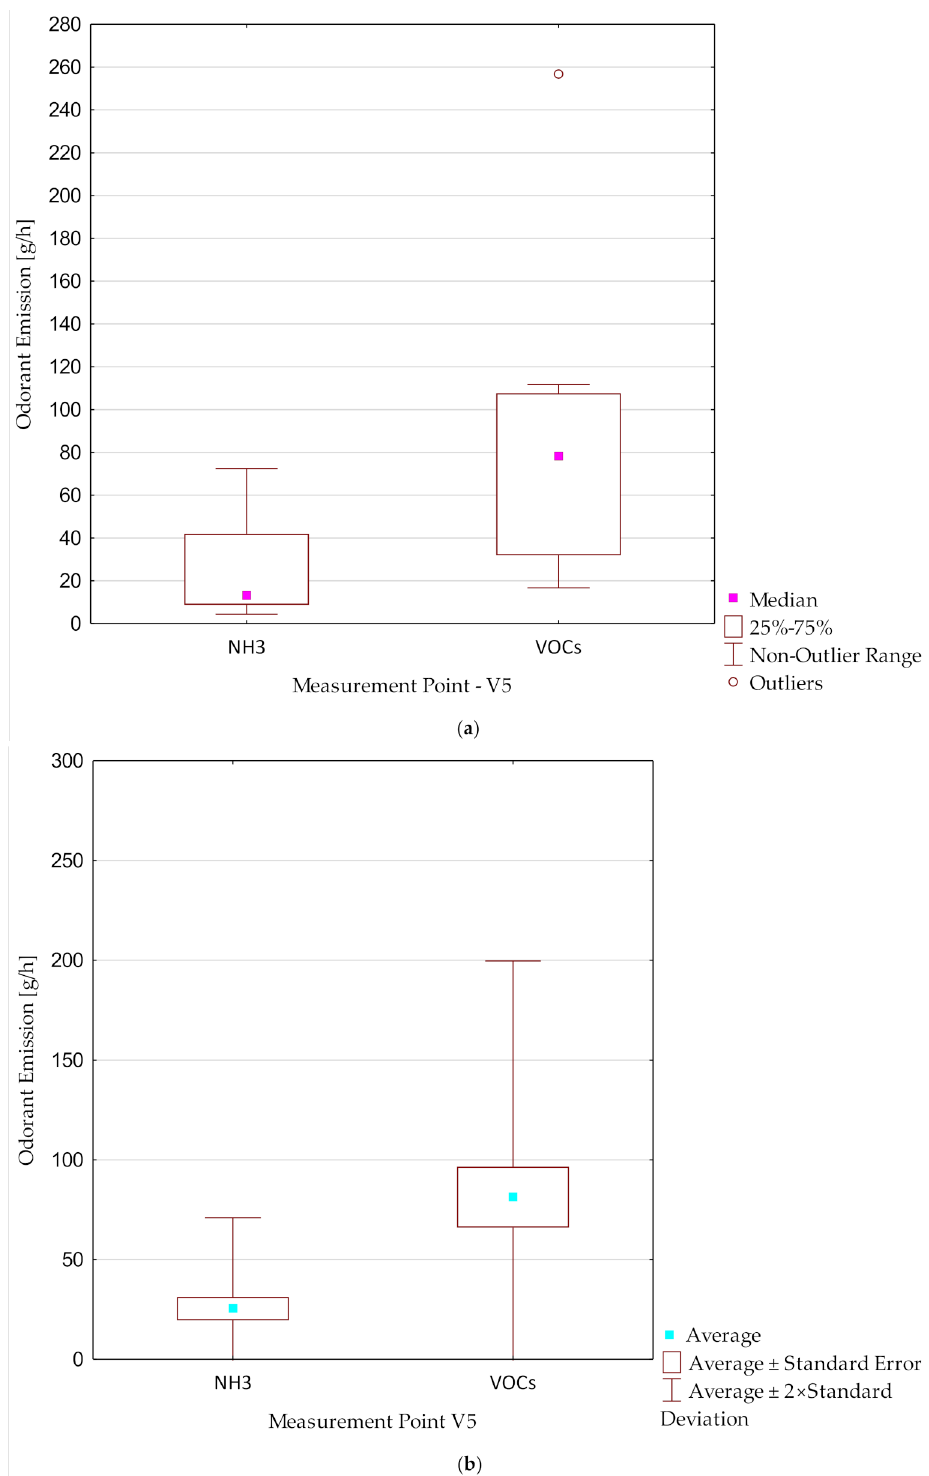
Figure 7. Odorant emission levels with median ( a ) and average ( b ) values at the fifth point in every measurement